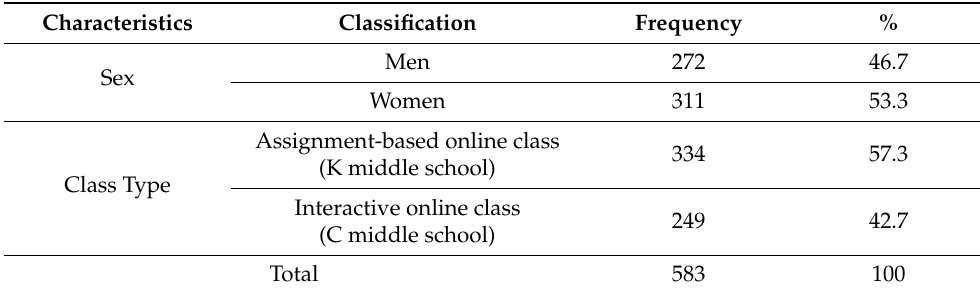
Table 1. Demographics of the study participants.